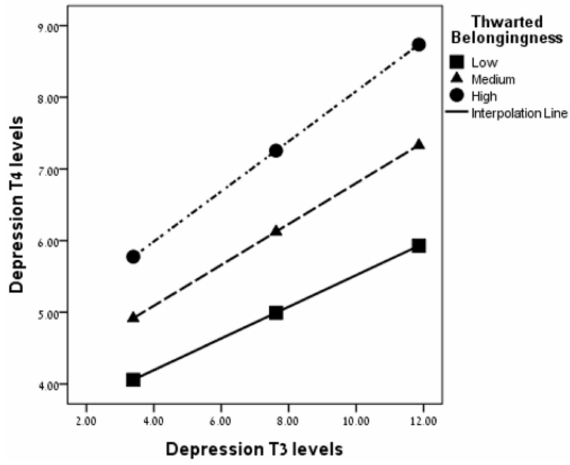
Figure 2. The moderation of thwarted belongingness on the association between depression-T3 and depression-T4 ( N = 152).